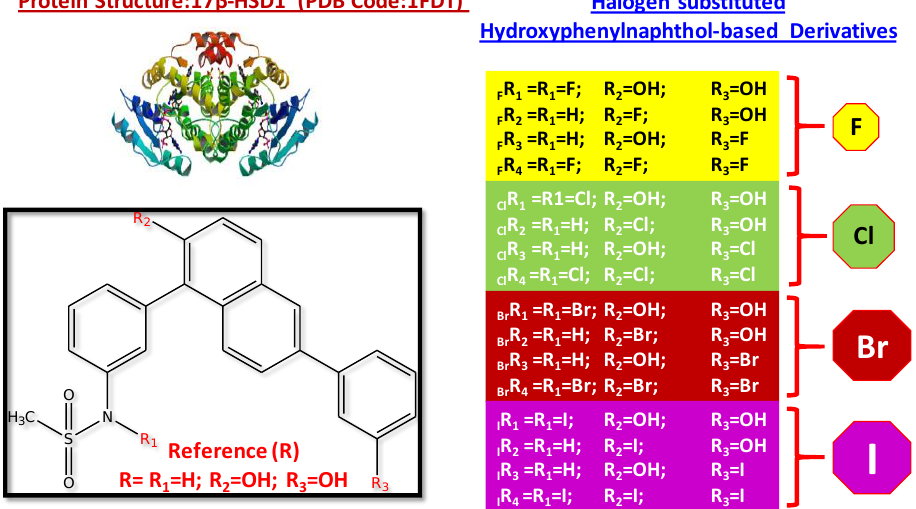
Scheme 1. Chemical structures of molecules considered for the present